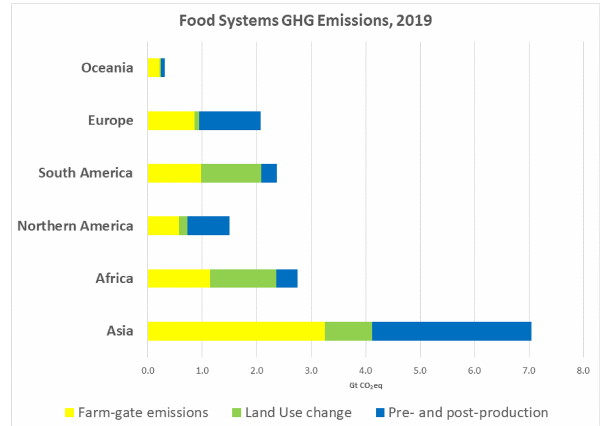
Figure 4. Total GHG emission from agri-food systems by FAO re- gions, 2019. Color bars show contributions by emissions within the farm gate (yellow), land use change (green), and pre- and post- production along food supply chains (blue). Source: FAOSTAT (FAO,